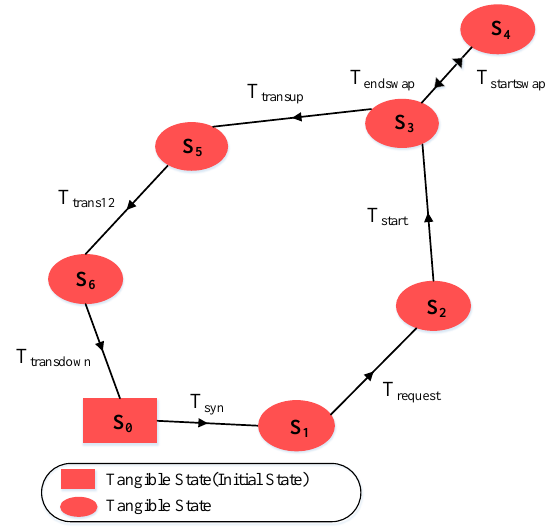
Figure 10. Reachability diagram of SPN model 1.